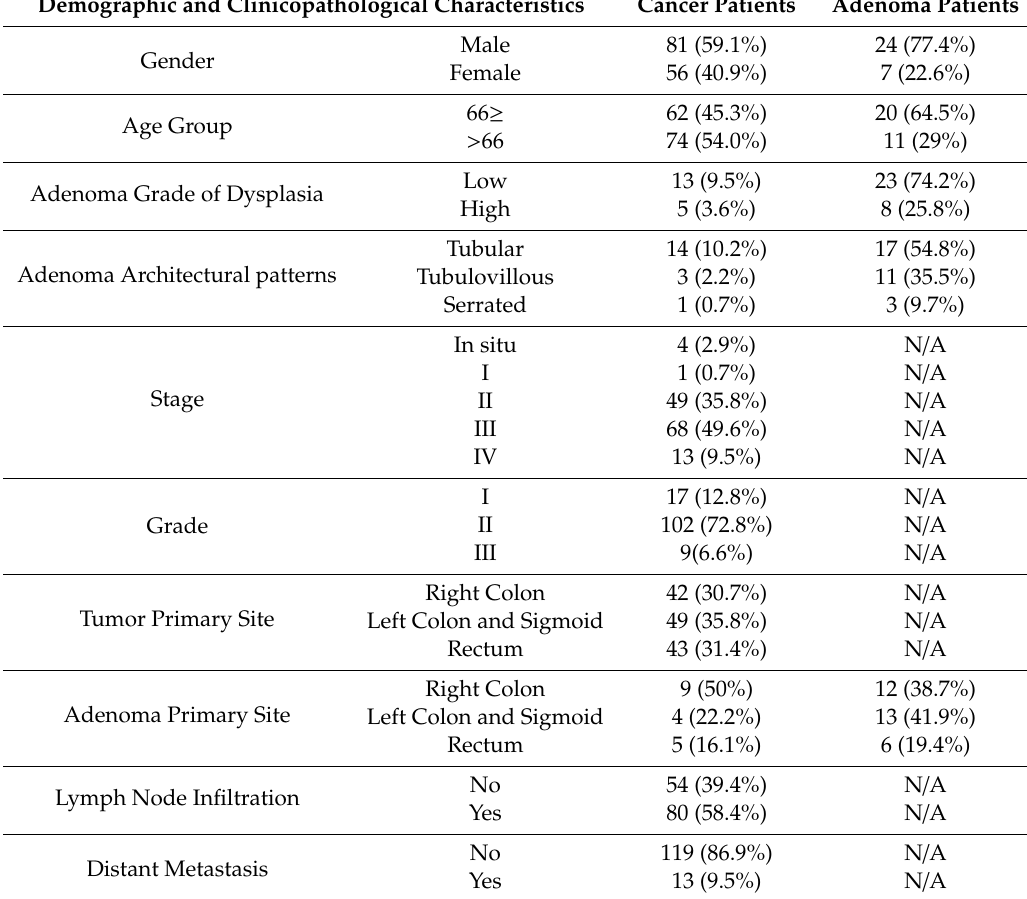
Table 1. Demographic and clinicopathological characteristics of CRC (colorectal cancer) and adenoma